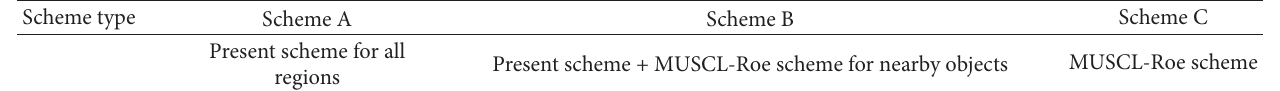
Table 1: Numerical schemes for estimating inviscid flux.